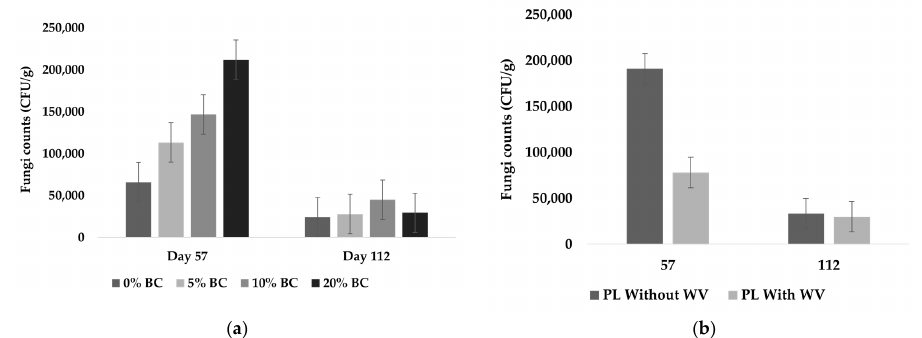
Figure 7. Fungi counts for all BC inclusion rates, including treatments with and without WV ( a ), and WV level ( b ) as independent fixed effects.